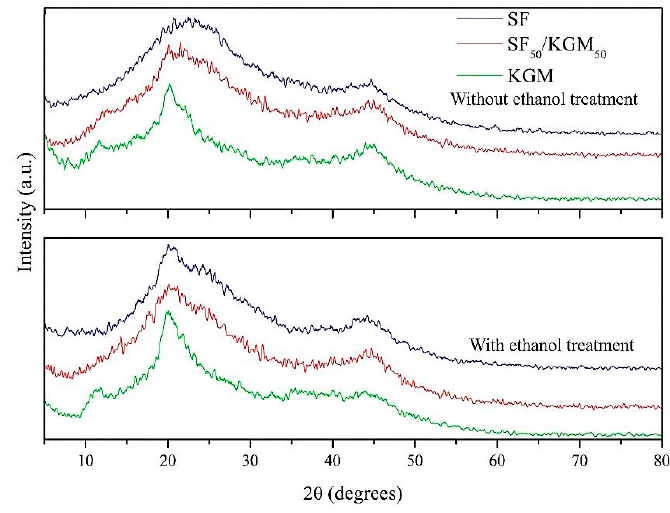
Figure 6. XRD diagrams of beads.